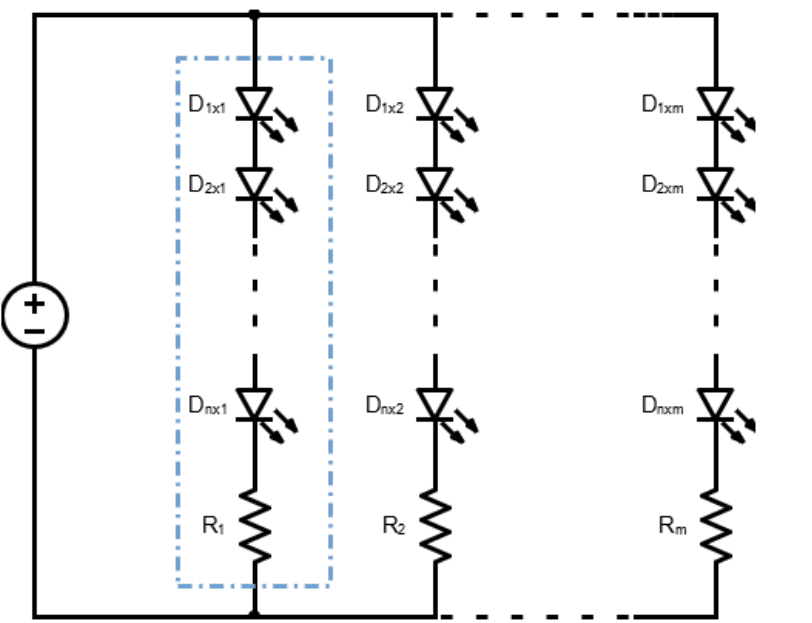
Figure 28. Equivalent circuit of the LED matrix formed by a LED strip. From this, one can deduce the voltage and current of the strip.